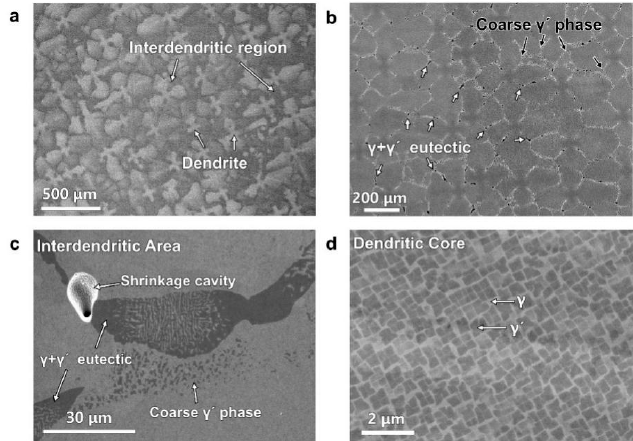
Figure 2. The cross-sectional microstructures of the as-grown Ni-based single crystal (SX) superalloy. ( a ) Backscattered electron (BSE) image showing the dendrite structure. Segregation of high-Z elements results in a bright contrast in the dendrite arm and dark contrast in the interdendritic region. ( b ) Secondary electron (SE) image showing the distribution of eutectics and coarse γ΄ phases at the interdendritic region. ( c , d ) Typical microstructures of interdendritic and dendritic core regions, respectively.